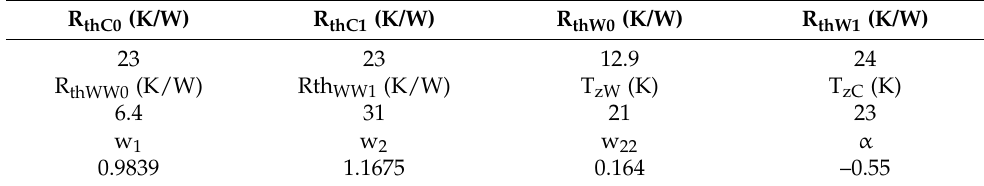
Table 3. Values of the thermal parameters of the coupled